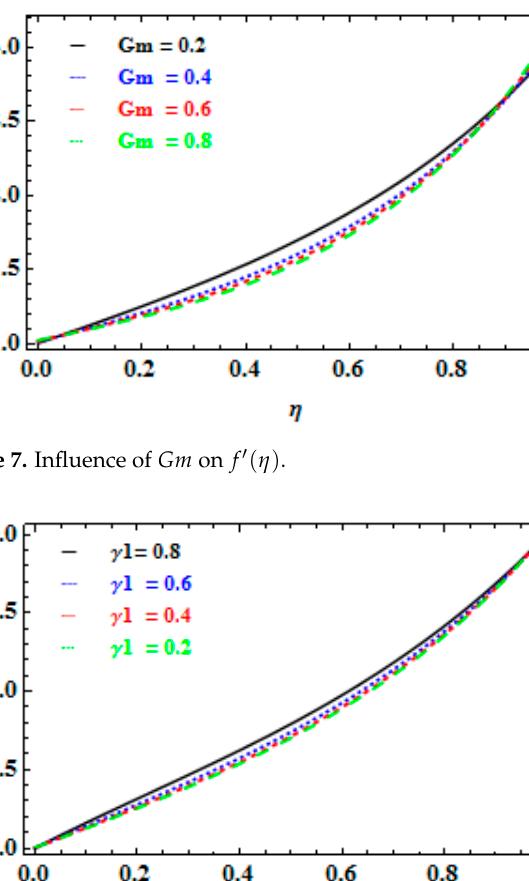
Figure 6. Influence of S t on f (cid:48) ( η ) .